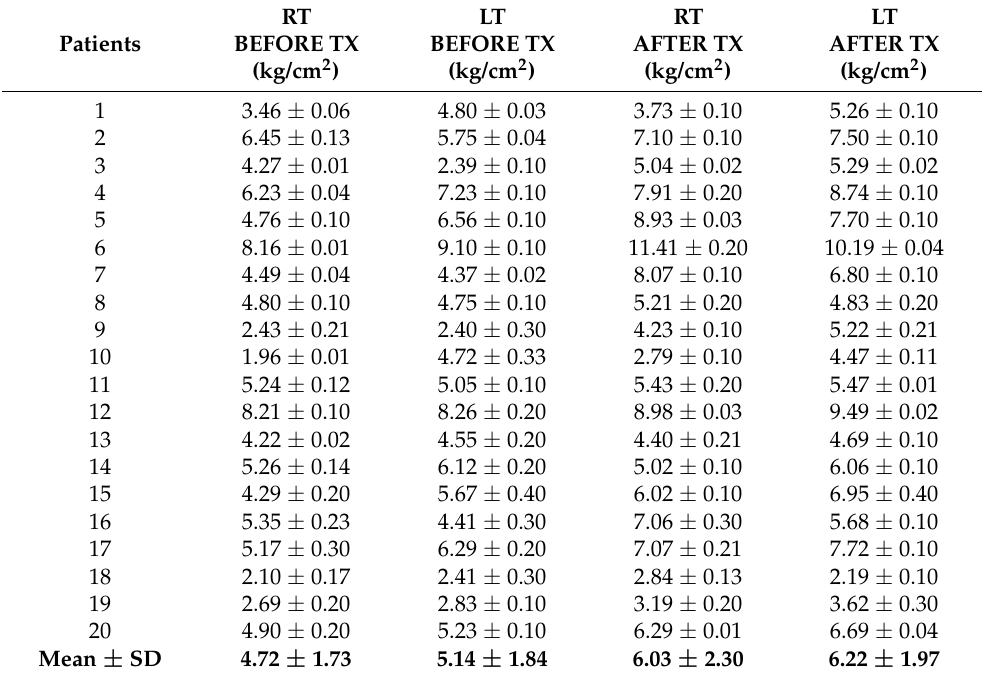
Table 2. Mean values and standard deviation of algometer measurements taken at the level of the right (rt) and left (lt) posterior inferior iliac spine (PIIS) in 20 subjects. The first and second columns report mean values at t0, while the third and fourth columns report mean values taken at t1. TX =